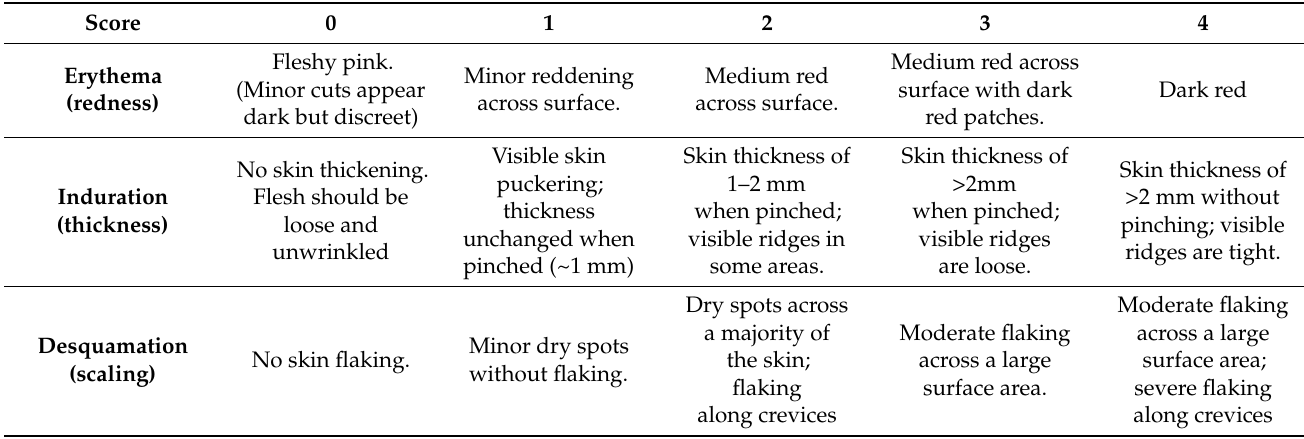
Figure 1. MPO deficiency ameliorates plaque psoriasis ear thickening. Plaque psoriasis was induced on the ears of wildtype C57BL/6 and Mpo − / − mice. Ears were measured at baseline prior to induction and then again on day five. Baseline ear thickness was subtracted from the final thickness per ear, shown as change in ( ∆ ) thickness. White circle = non-induced WT ear; white triangle = non-induced Mpo − / − ear; black circle = induced WT ear; black triangle = induced Mpo − / − ear. Data include two replicate experiments each containing 3–4 mice per group. Each data point represents one mouse. * p ≤ 0.05. Table 1. Description of mouse PASI